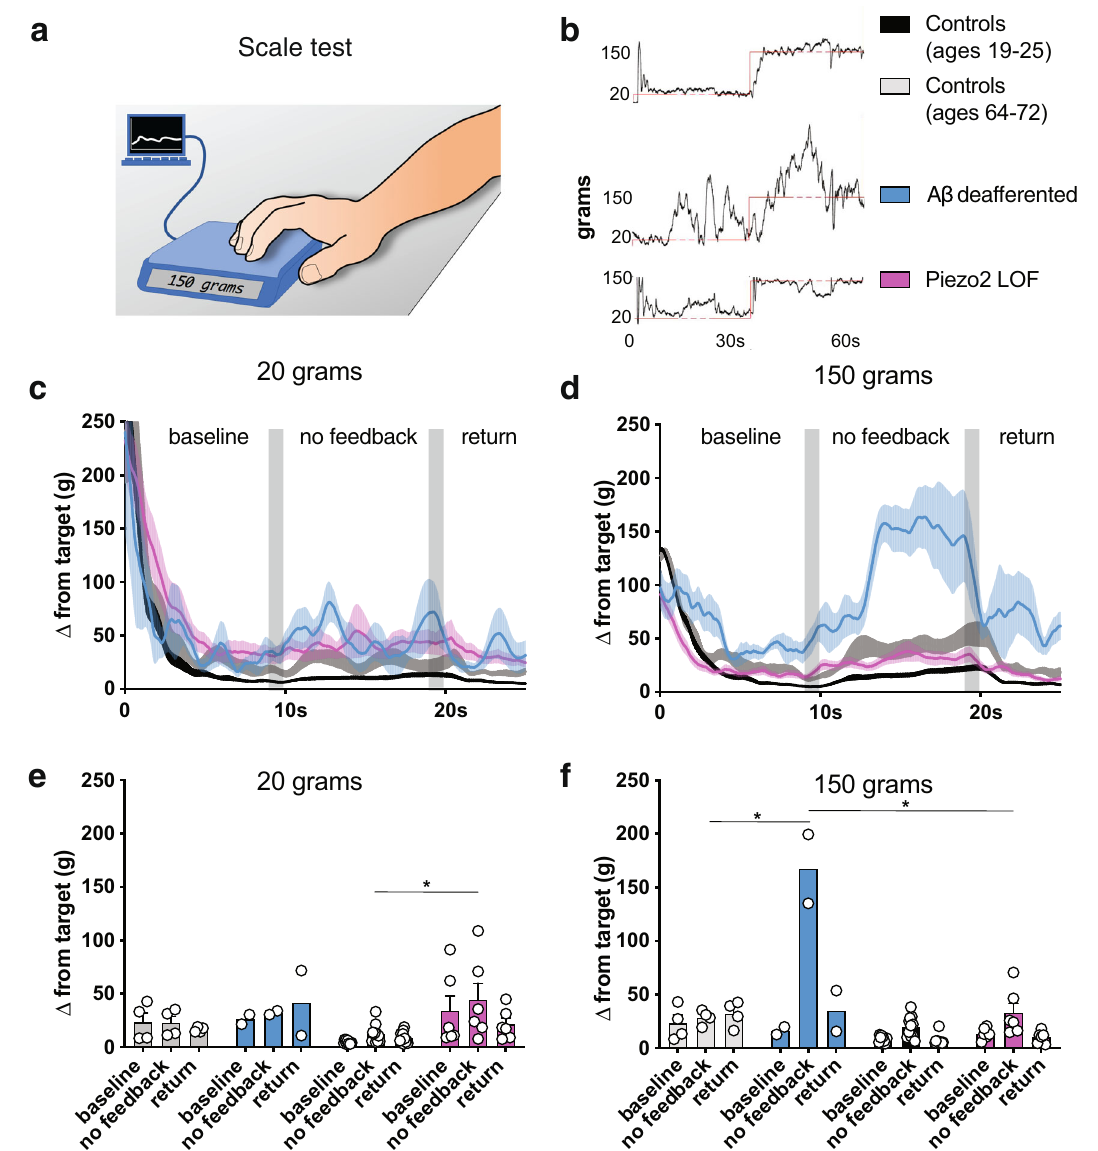
Fig. 4 De fi cits in pressure sensation impair performance in an active mechanosensation task. a Cartoon depicting the digital scale developed to quantify active pressure sensing. Participants applied pressure with their fi ngertips to match a target on the computer screen. b Example force trace from a control participant. Participants attempted to match their force readout (black) to the target (red) at 20 g (cutaneous) and 150 g (putative deeper pressure). After 15 s the line disappeared (dotted red lines) and participants were instructed to maintain their applied force for 10 s (no feedback; gray bar). Afterwards, the line reappeared before moving to the next value. c Mean deviation from target value over 1 s at 20 g in controls (gray and black traces, N = 17), A β - deafferented patients, (blue, N = 2) and ΡΙΕΖΟ 2 LOF (magenta, N = 6). Bars display standard error. d Mean deviation from target value over 1 s at 150 g. ΡΙΕΖΟ 2 LOF patients ( N = 6) did not signi fi cantly differ in maintaining 20 versus 150 g without visual feedback (one-sided permutation test p = 0.70); younger healthy controls ( N = 11) were poorer at 150 g (trend; one-sided permutation test p = 0.06). A β -deafferented participants ( N = 2) appeared worse at 150 g without visual feedback, though this difference was not signi fi cant (one-sided permutation test p = 0.24); older controls ( N = 6) were poorer at 150 g (one-sided permutation test p = 0.046). Bars display standard error. e Alternate representation of target deviation at 20 g (average error in fi nal 5 s of each interval; + = visual feedback and − = no feedback). Both A β -deafferented ( N = 2; blue) and ΡΙΕΖΟ 2 LOF ( N = 6; magenta) participants had more dif fi culty without visual feedback than older ( N = 6) and younger ( N = 11) healthy controls (one-sided permutation tests p = 0.18 and * p = 0.007, respectively). Bars display standard error. f Alternate representation of target deviation at 150 g. Both A β -deafferented ( N = 2) and ΡΙΕΖΟ 2 LOF ( N = 6) participants had more dif fi culty than older ( N = 6) or younger ( N = 11) controls (one-sided permutation test * p = 0.03 and p = 0.06, respectively), and A β - deafferented patients had greater dif fi culty than ΡΙΕΖΟ 2 LOF participants (one-sided permutation test * p = 0.03). Bars display standard Patient and matched healthy control testing . Two patients with a rare sensory 67, 68, and 72) participated as controls for the A β -deafferented group. Seven individuals with inherited loss-of-function mutations in the mechanically-gated ion neuronopathy syndrome causing A β -deafferentation (female aged 69 and male channel ΡΙΕΖΟ 2 ( ΡΙΕΖΟ 2 De fi ciency Syndrome) also participated: three females aged 65), who have been previously studied (e.g., 19 ), participated in the deep (aged 12, 32, and 36) and four males (aged 14, 16, 19 and 43). One of these pressure discrimination, detection threshold, and sensory integration testing. Eight participants had a medical contraindication (deep vein thrombosis) for leg neurologically intact adults (4 females aged 64, 67, 69, and 69 and 4 males aged 65,